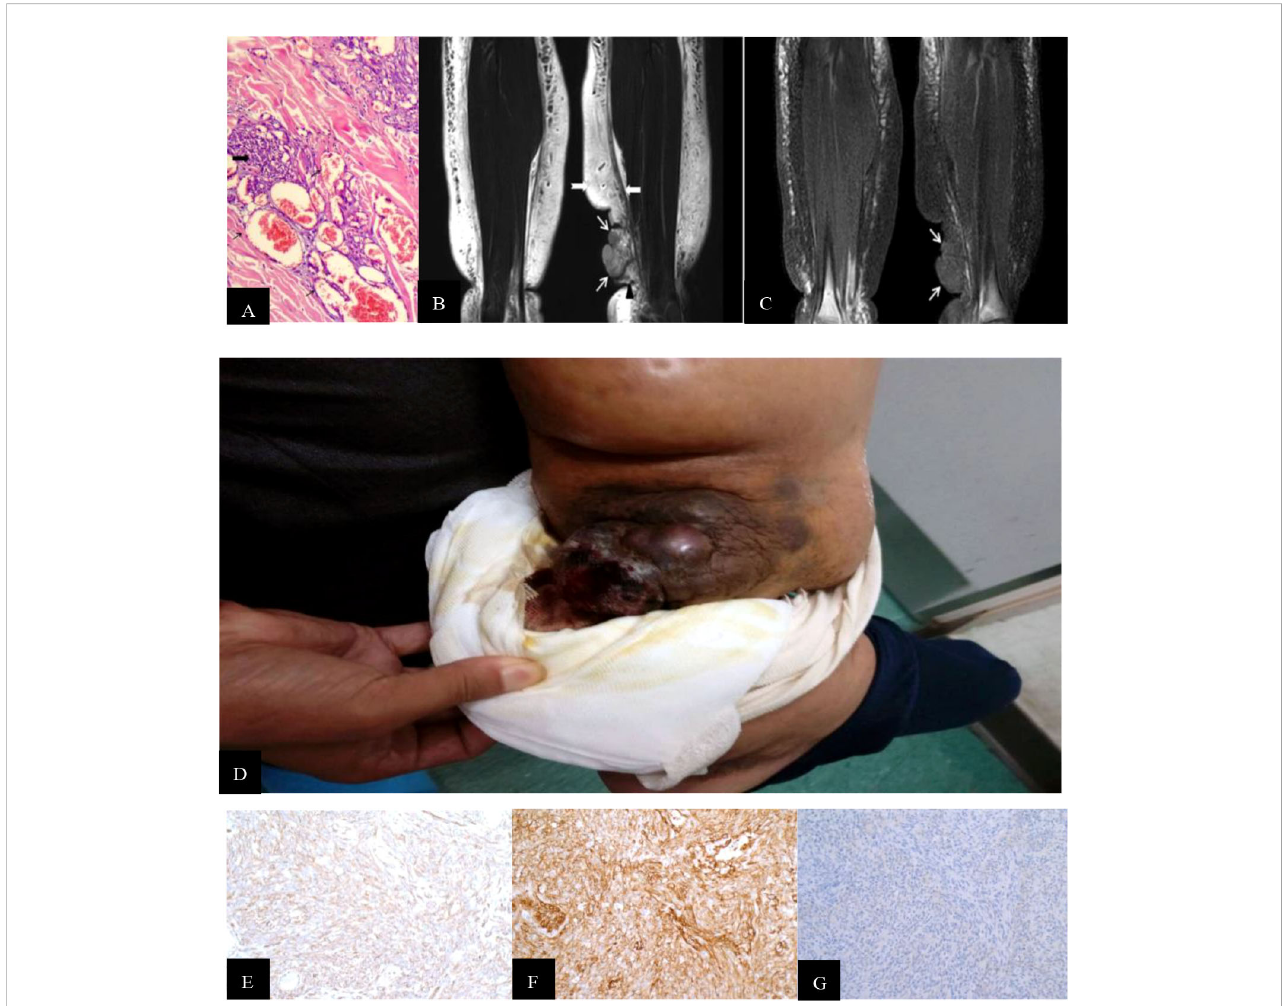
FIGURE 1 (A) Hematoxylin-and-eosin-stained histopathology of the M200 STS-PLE I type: the tumor nests were composed predominantly of densely atypical epithelioid cells displaying hyperchromatism (wide black arrowhead). The spindle endothelial cells lined immature vessels, with erythrocytes detected inside the vessels ( fi ne black arrowhead) and distributed in collagen fi ber stroma (+). (B) Coronal T2WI identi fi ed a mass-like shape ( fi ne white arrowhead) located in the subcutaneous soft tissue of the left medial malleolus. Its signal was heterogeneously decreased against the background of lymphedema. If compared with normal muscle, the tumor signals are increased heterogeneously on the T2WI. The extensive lymphedema (swallow-tail white arrowhead) is indicated by an abnormally thickened super fi cial fascia (wide white arrowhead) and adjacent thickened skin. (C) Corresponding T1WI signal of STS was slightly decreased compared with the normal muscle ( fi ne white arrowhead). (D) A large mass was located and protruded in the surface of the lower leg, and presented as a dark red super fi cial ulcer with hemorrhagic discharge, dark-red spots, and increased skin temperature. (E, F) CD31 and CD34 staining were positive (magni fi cation, x200). (G) D2 40 staining was partially positive (magni fi cation,